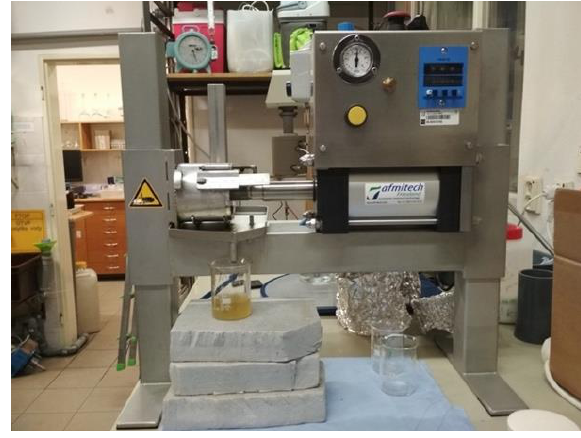
Figure 2. Laboratory mini-press (Mareco MMP-3/2).